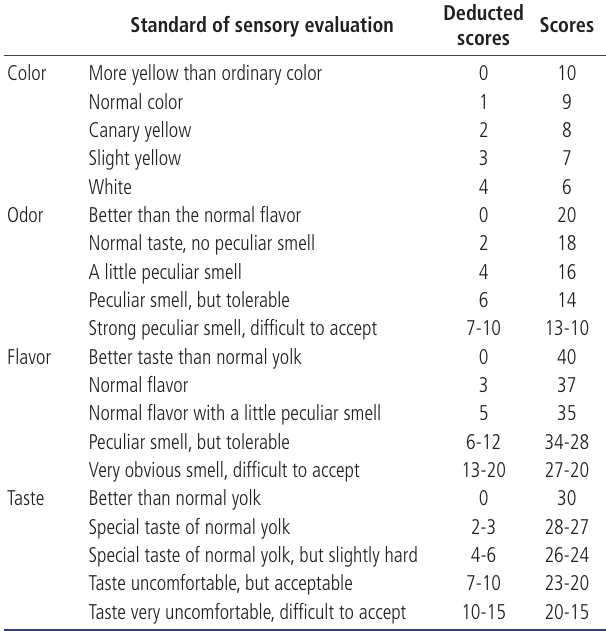
Table 2. Standards of yolk sensory evaluation 1)